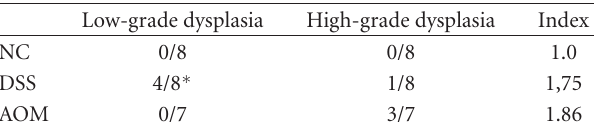
Table 2: Histological evaluation. Histological evaluations of colonic samples. Number of animals showing the histopathologic lesion per total number analysed samples in the group and an index calculated on the basis of the scoring